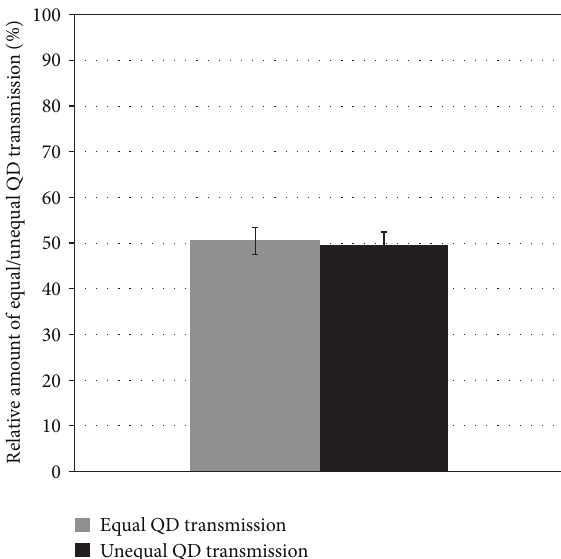
Figure 7: Distribution of equal and unequal cell divisions in QD labeled cell populations. The relative amount of cell divisions with equally and unequally transferred QDs was quantified by analyzing time lapse picture series of four experiments. In total, 242 cell divisions were prorated to the equal and unequal way of QD transmission.